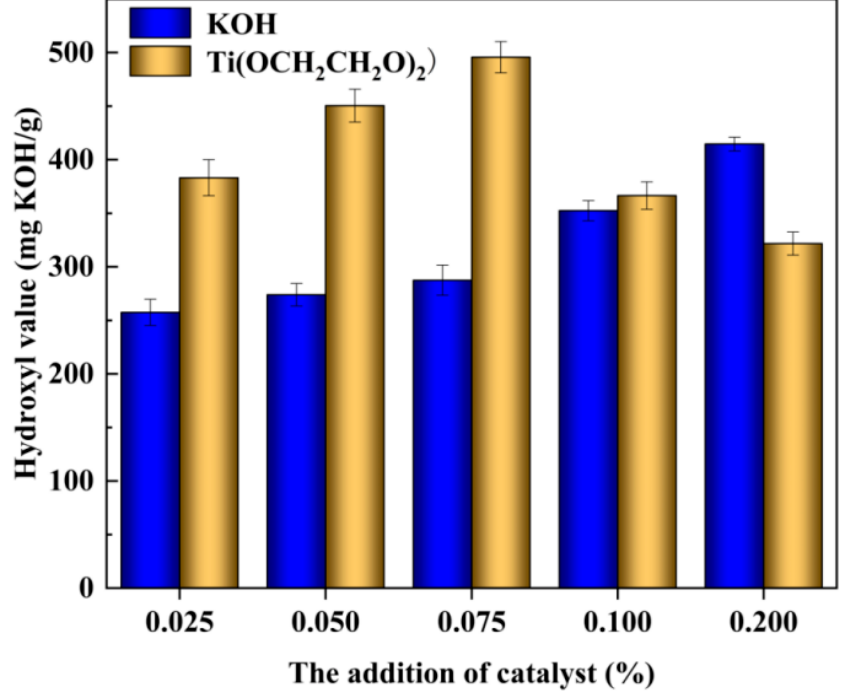
Figure 11. Determination of the hydroxyl value of the regenerated polyether polyol under different catalytic systems.